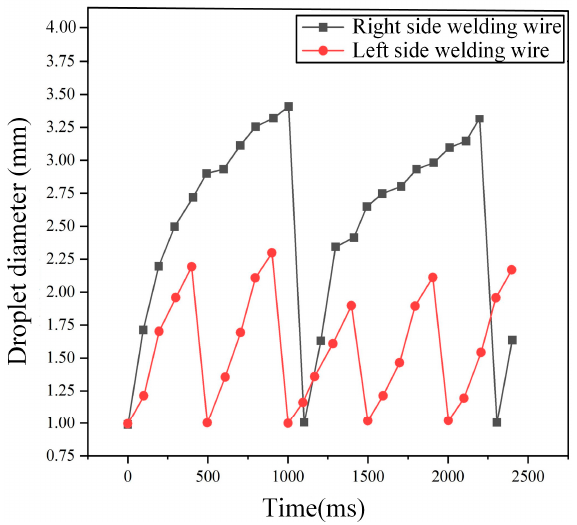
Figure 6. Changes in droplet size in the mode of “bridge transfer + free